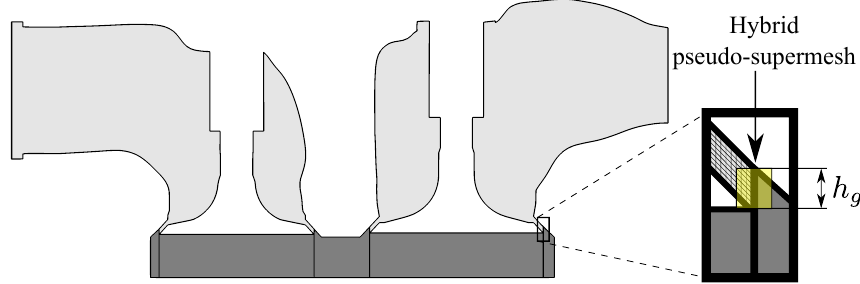
Figure 8. Detail of the valve gap modeling with hybrid